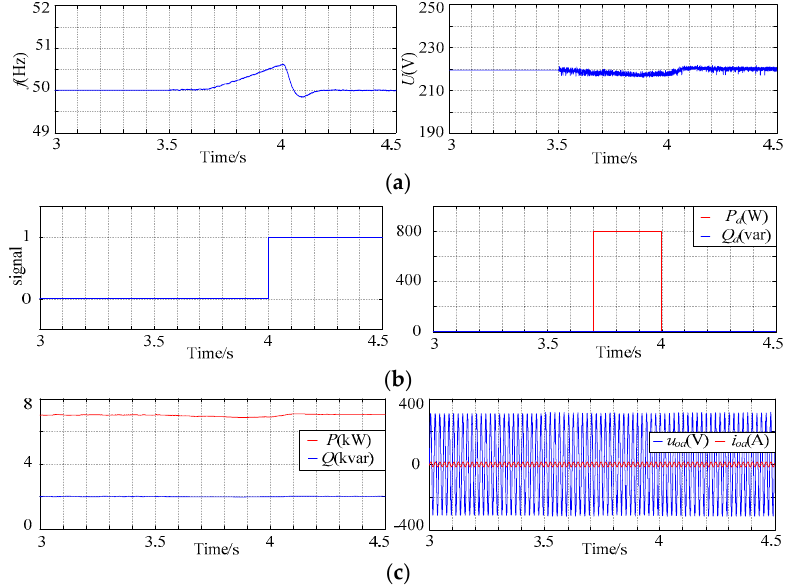
Figure 14. The process of islanding detection when power balanced: ( a ) The output voltage frequency and ampitude of the inverter; ( b ) The signal of islanding detection and the power disturbance; ( c ) The output power and the A phase voltage and current of inverter.